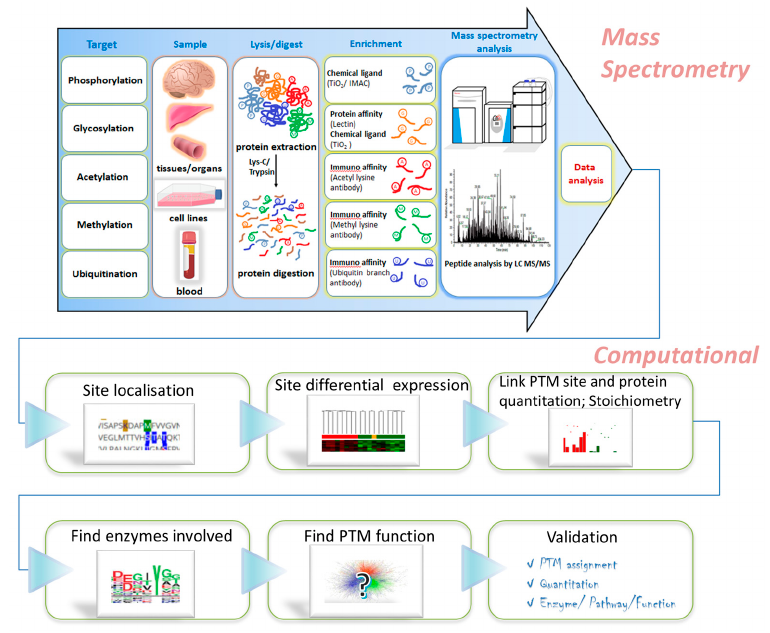
Figure 1. Schematic PTM Workflow illustrating some of the common steps associated with sample preparation, PTM enrichment, MS and bioinformatics analysis.